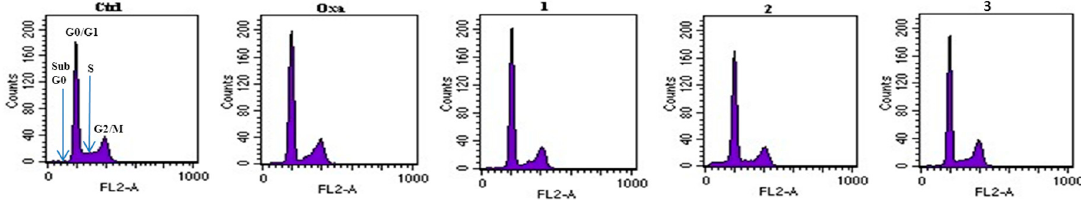
Figure 9. Flow cytometric analysis of LoVo cells stained with propidium iodide after 24 h of treatment with test compounds.